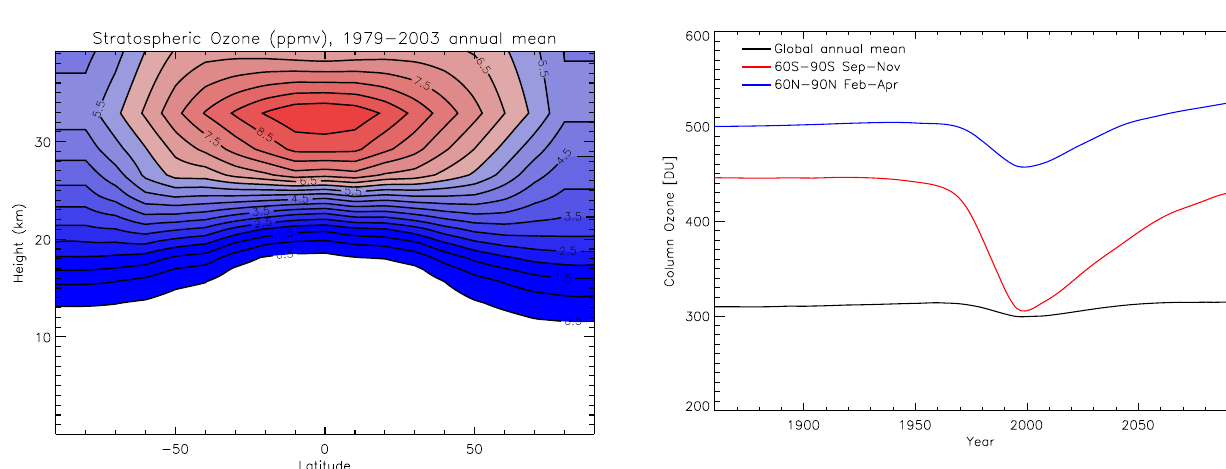
Fig. 8. Annual mean climatology of ozone volume mixing ration (ppmv) for 1979–2003.